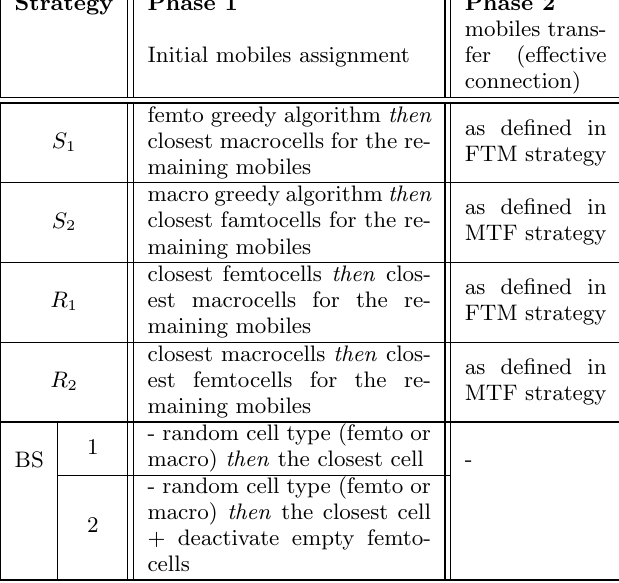
Table 1: Considered